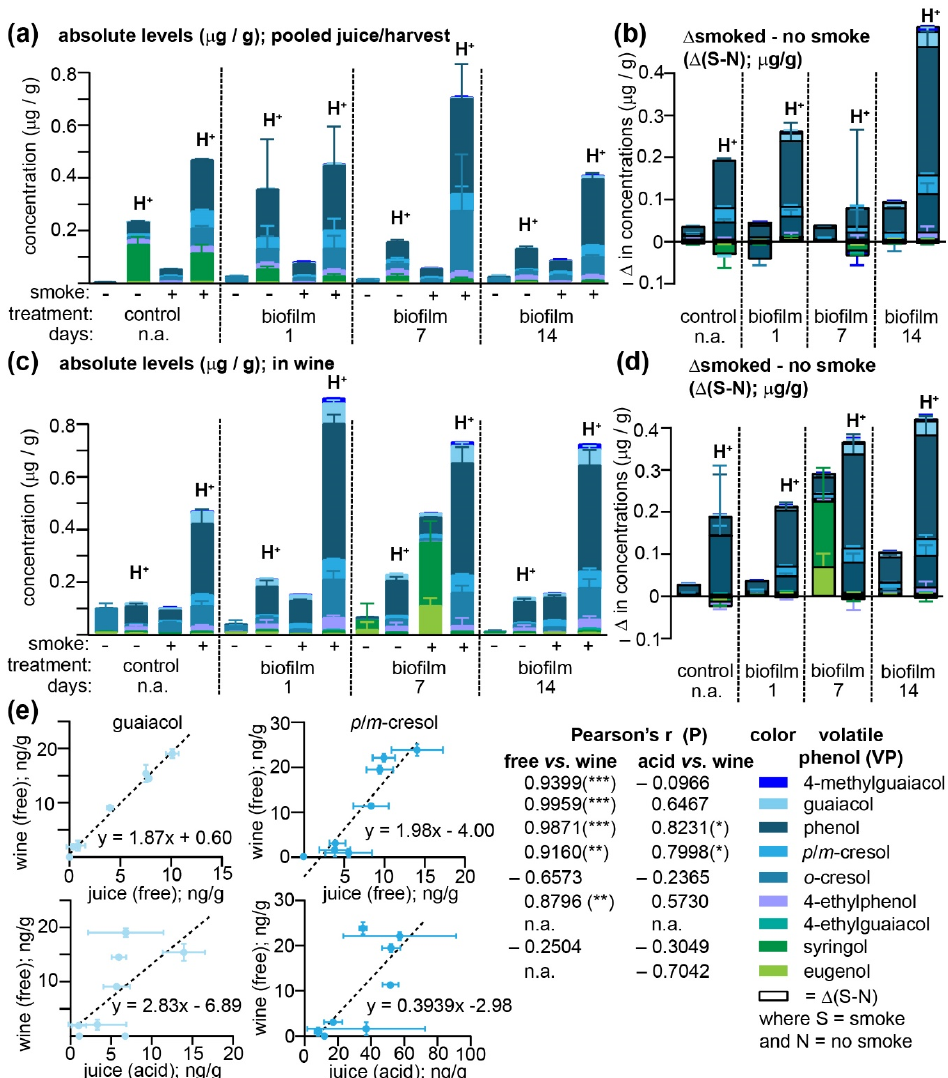
Figure 4. Fate of endogenous or smoke-derived, free and acid-labile VPs during the fermentation of Pinot Noir grapes subjected to differing biofilm treatments. The concentrations of both free and acid-labile (H + ) VPs were quantitated by GC–MS in ( a ) Pinot Noir must/juice pooled from the biofilm study and ( c ) the resulting wines. Differences ( Δ ) in VP concentrations between the smoke-exposed (S) and non-treated (N) must ( b , d ) wine samples were determined and are depicted with histograms outlined with a black boarder. Error bars depict the standard error of the mean ( a , c ) or their sum in quadrature ( b , d ). ( e ) Pearson’s correlation coefficients between the concentrations of free or acid-labile VPs in the must/juice vs. the free, aroma-active forms in wines were calculated to deduce which must/juice measurement most closely correlated with the wines. Example linear regressions are only depicted for guaiacol and p / m -cresol. *, **, and *** indicate p < 0.05, 0.01, and 0.005, respectively.